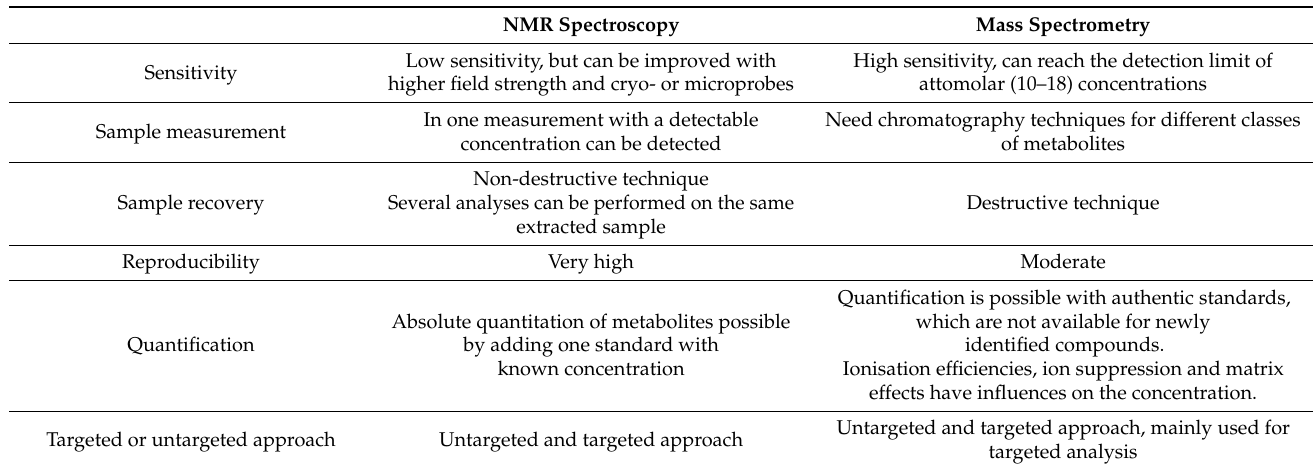
Table 1. The advantages and limitations of NMR spectroscopy and mass spectrometry for metabolic profiling